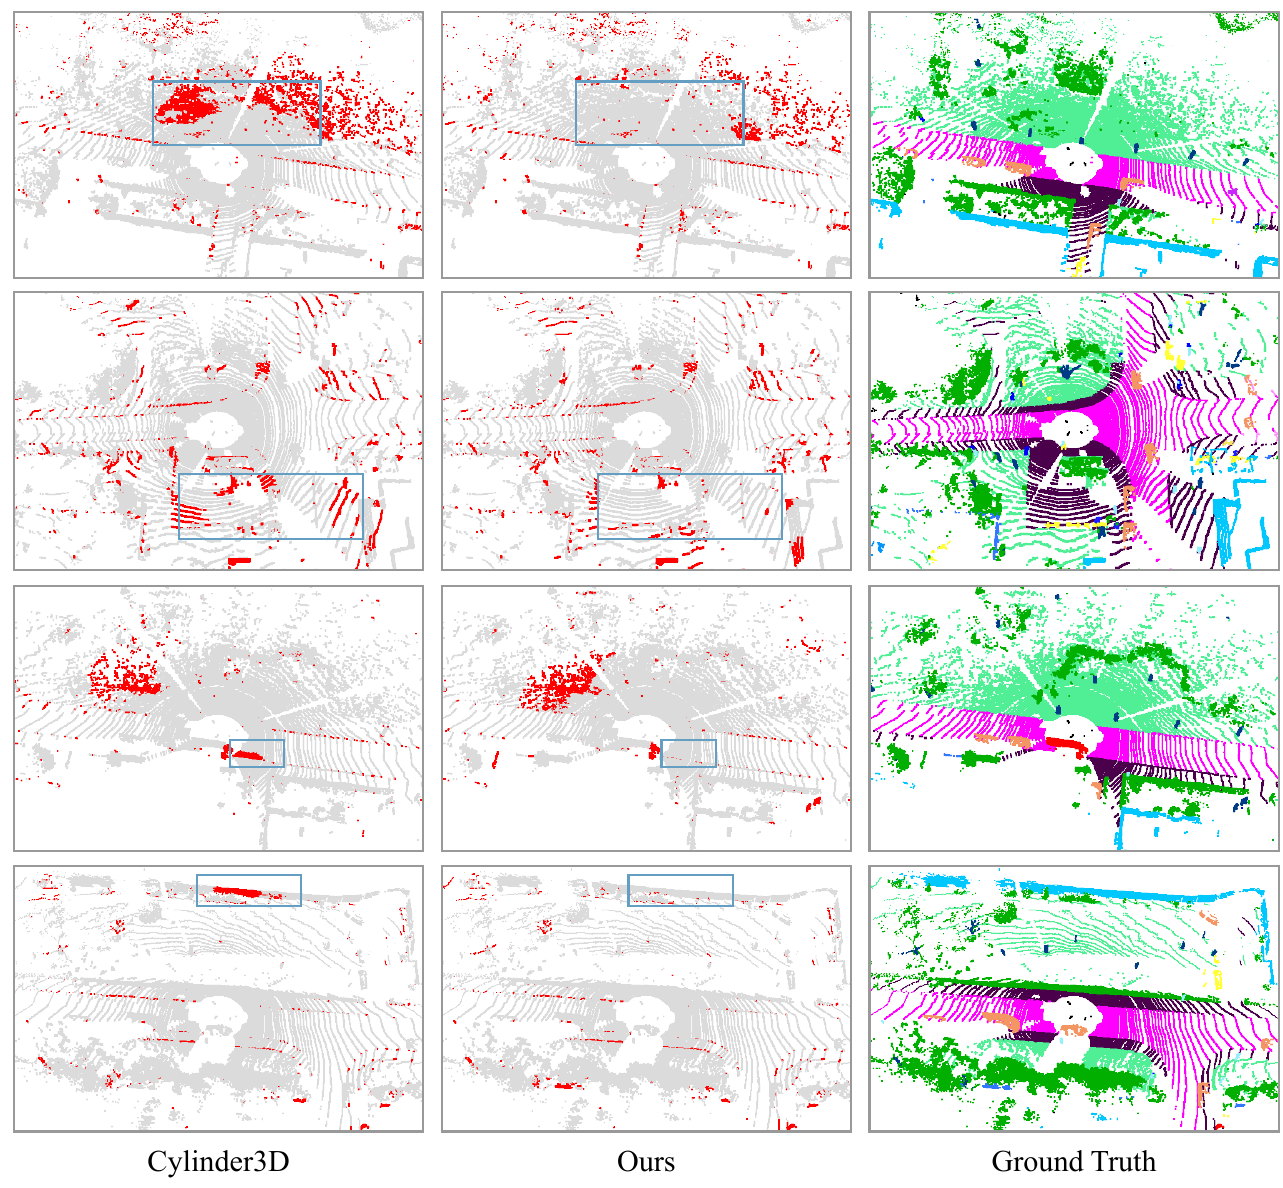
Figure 3. Compared to Cylinder3D, our method had less error (shown in red) when recognizing the surface region on the SemanticKITTI dataset’s validation set, thanks to the voxel-based sparse multi-head attention module. Best viewed in